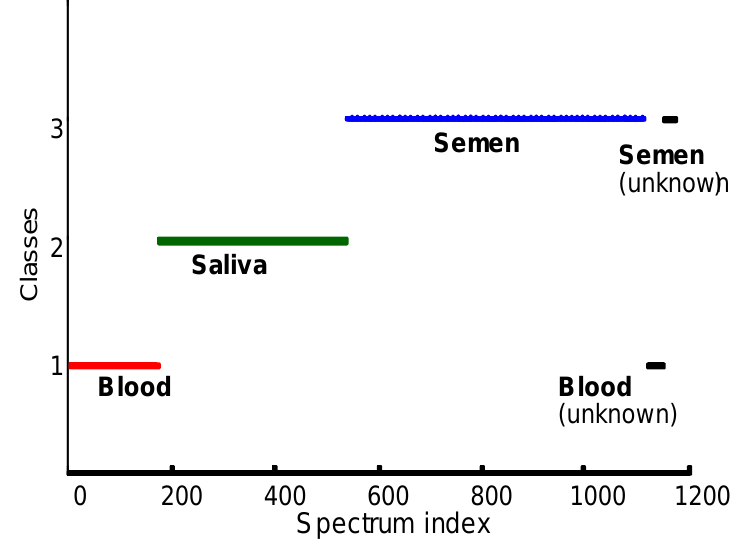
Figure 4. Linear discriminant analysis of the body fluids. Classes defined by training sets: human blood (red)–class 1 , human saliva (green)–class 2, human semen (blue)–class 3. Black color indicates unknown